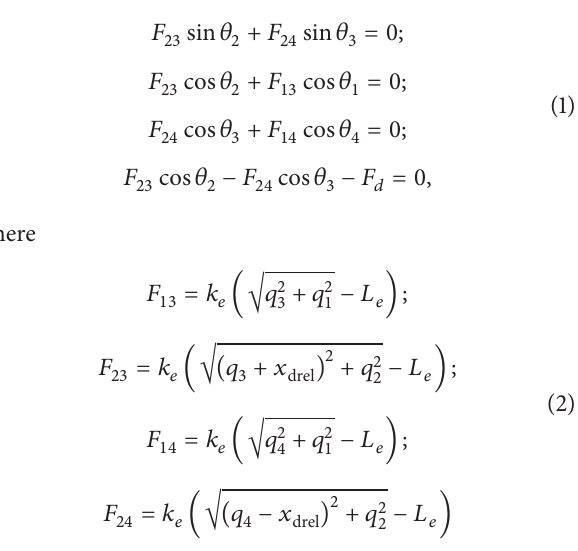
measured positive rightward. Equilibrium of joints 2, 3, and